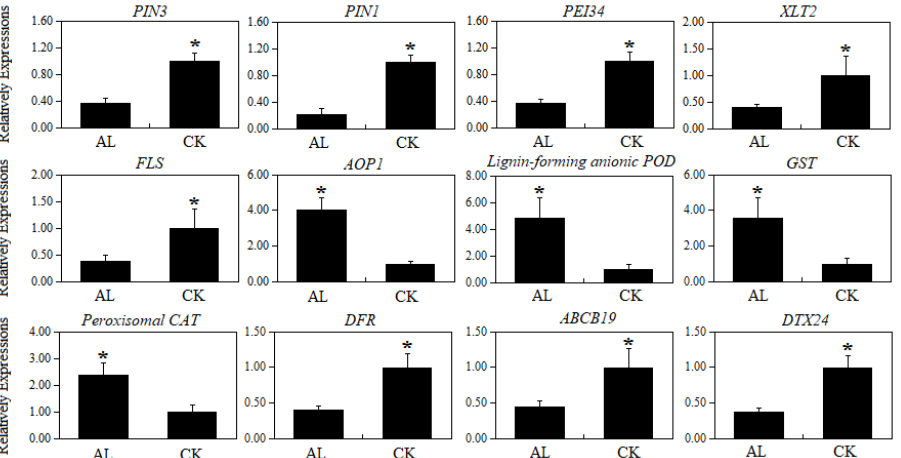
Figure 8. qRT-PCR–based expression analyses of representative genes that are differentially expressed according to the RNA-Seq results ( p < 0.05). The asterisk (*) represents a significant difference betweent normal conditions and Al 3+ stress.